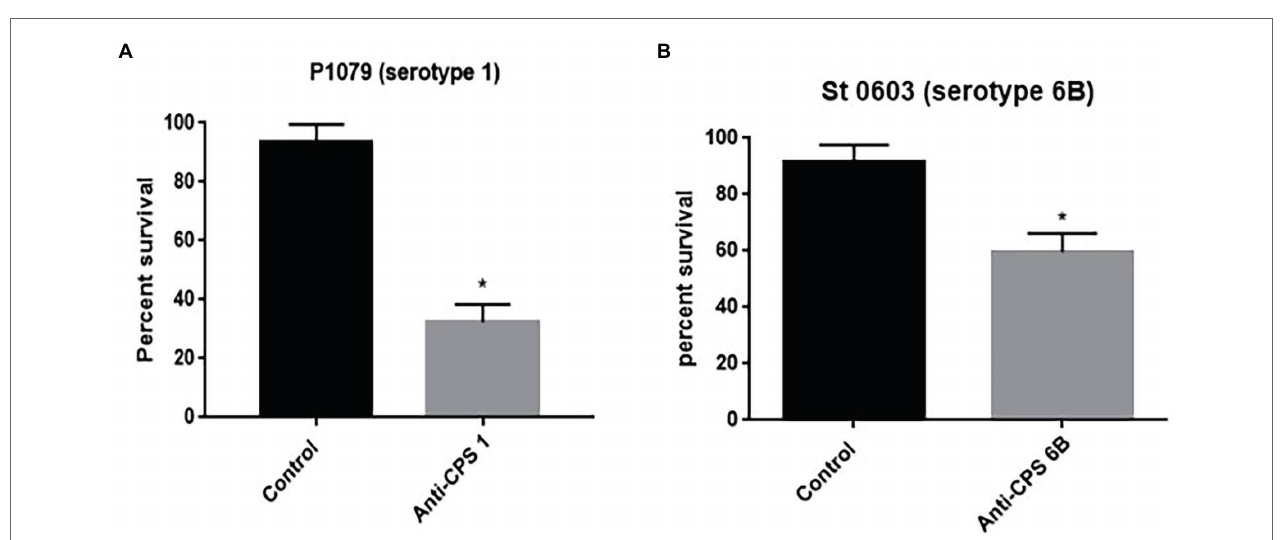
FIGURE 5 | Effect of anticapsular antibodies on the lytic action of indolicidin. Peumococcal strains St 1,079, serotype 1 (A) and 0603, serotype 6B (B) were incubated with sera from mice immunized with CPS 1 and 6B, respectively, prior to treatment with indolicidin. The control group was incubated with sera from sham immunized mice. The percentage of bacteria surviving treatment is shown for each group. Statistical analysis was performed using Student’s t -test. * p < 0.05 in comparison with the